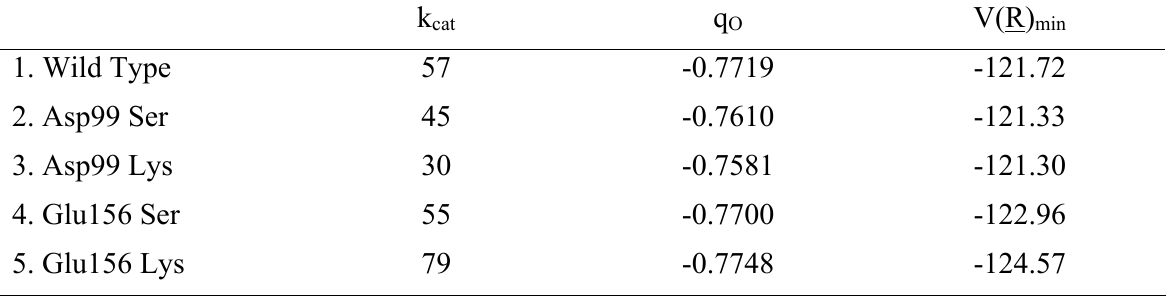
values (s -1 ) and calculated charges q cat k